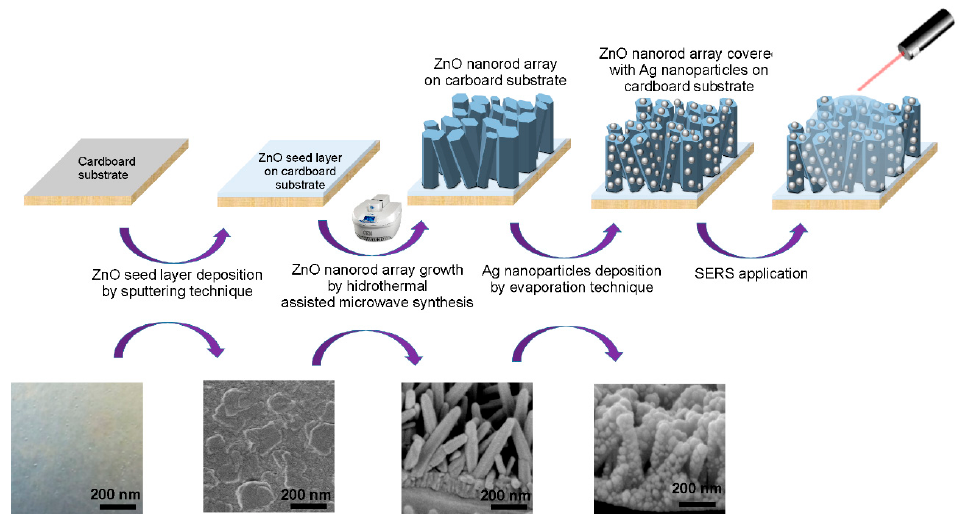
Figure 10. Schematic of the production process of ZnO nanorod arrays by hydrothermal synthesis assisted by microwave radiation and decorated with Ag nanoparticles, on cardboard substrates, for surface-enhanced Raman scattering (SERS)